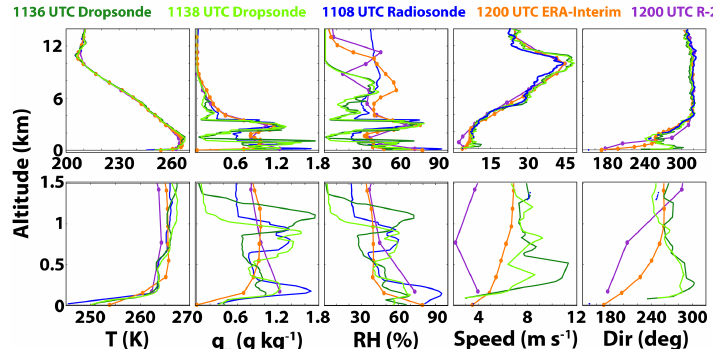
Figure 6. Plot of the Barrow Weather Forecast Office radiosonde launched (blue line) at 11:08UTC on 10 March 2011, the Global Hawk dropsondes (green lines) at 11:36 and 11:38UTC 10 March 2011, and ERA-I (orange) and R-2 (purple) reanalysis profiles (12:00UTC 10 March 2011) interpolated in space to the averaged dropsonde location for the entire profile depth (top) and lower atmosphere (bottom). Included are (from left to right) temperature (K), specific humidity (gkg − 1 ) , relative humidity (%), wind speed (ms − 1 ) , and wind direction